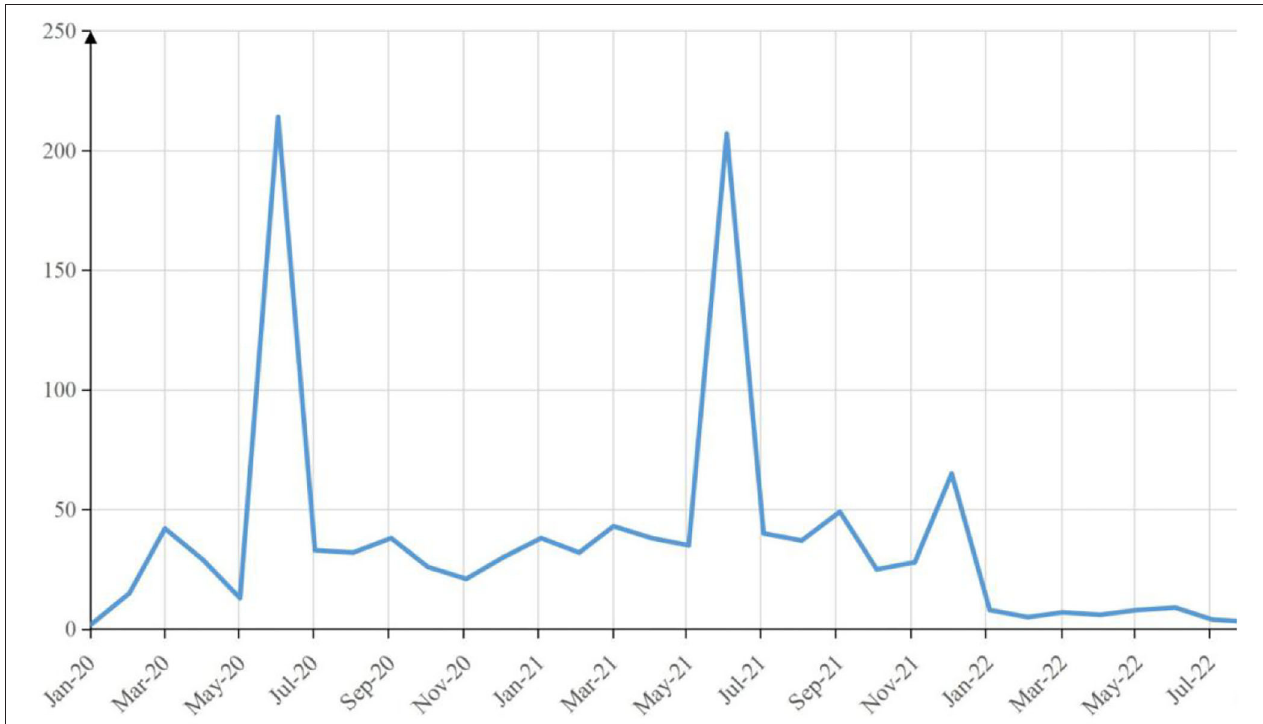
FIGURE 1 | The volume of COVID-19 and mental health-related articles in 2020–2022.